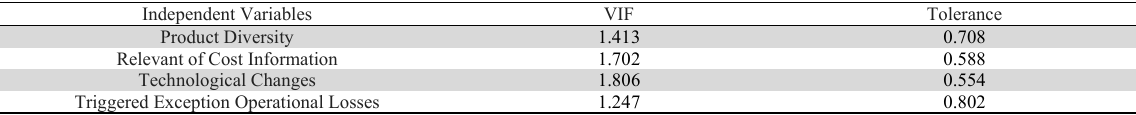
Variance Inflation Factor and